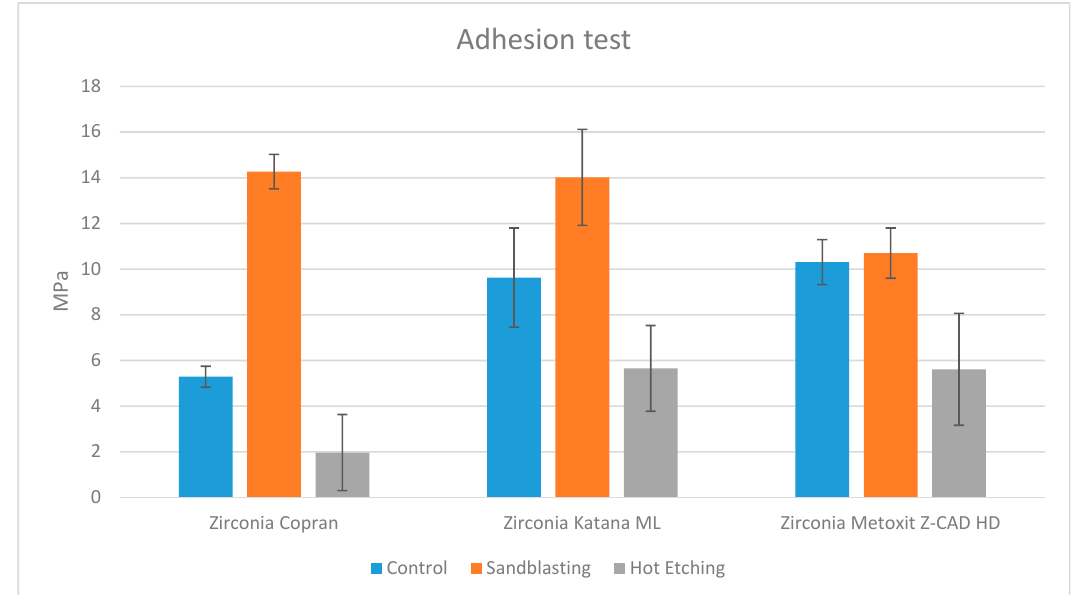
Figure 4. Shear forces of the groups tested.